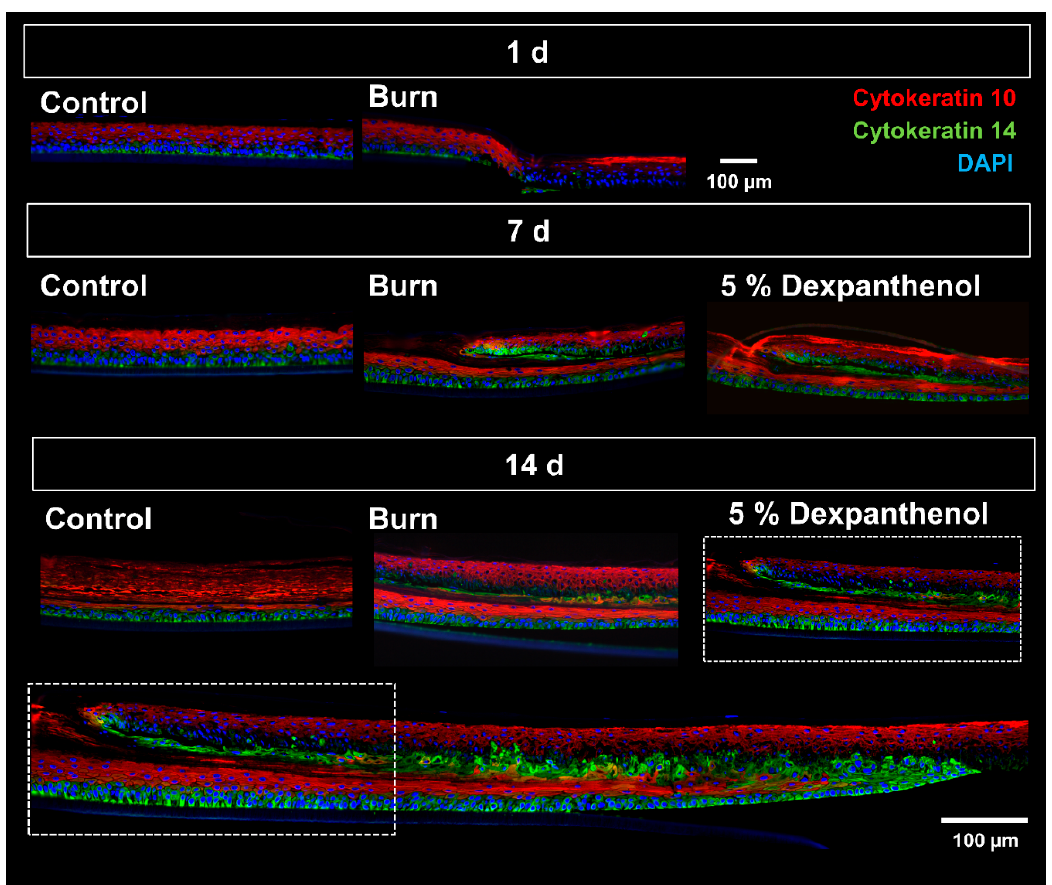
Figure 3. Immunofluorescence staining of the OS-REp models after burning and regeneration. Immunofluorescence staining of Cytokeratin 10 (K 10), Cytokeratin 14 (K 14) and DAPI of control, burned and treated OS-REp models. Cell nuclei stained with DAPI are illustrated in blue. K 10 in red shows the differentiated layer of the epidermis, while K 14 in green defines undifferentiated stratum basale. On day 14, an additional overview image of a treated OS-REp model is shown to demonstrate the whole wound edge and wound tongue (the images in the boxes show the same region of the model). (Images from 1 out of 3 biological replicates in independent test runs with 1 technical replicate each).